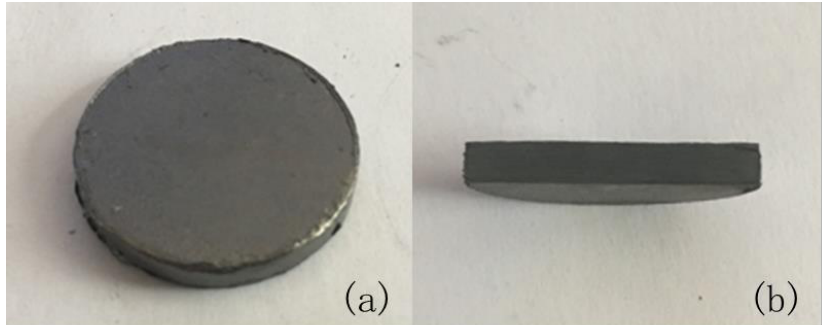
Figure 3. The appearance of the silicon carbide fiber/paper-derived silicon carbide (SiC f /SiC p ) composite sintered at 2100 °C and 40 MPa for 10 min. ( a ) plan view; ( b ) cross section view.